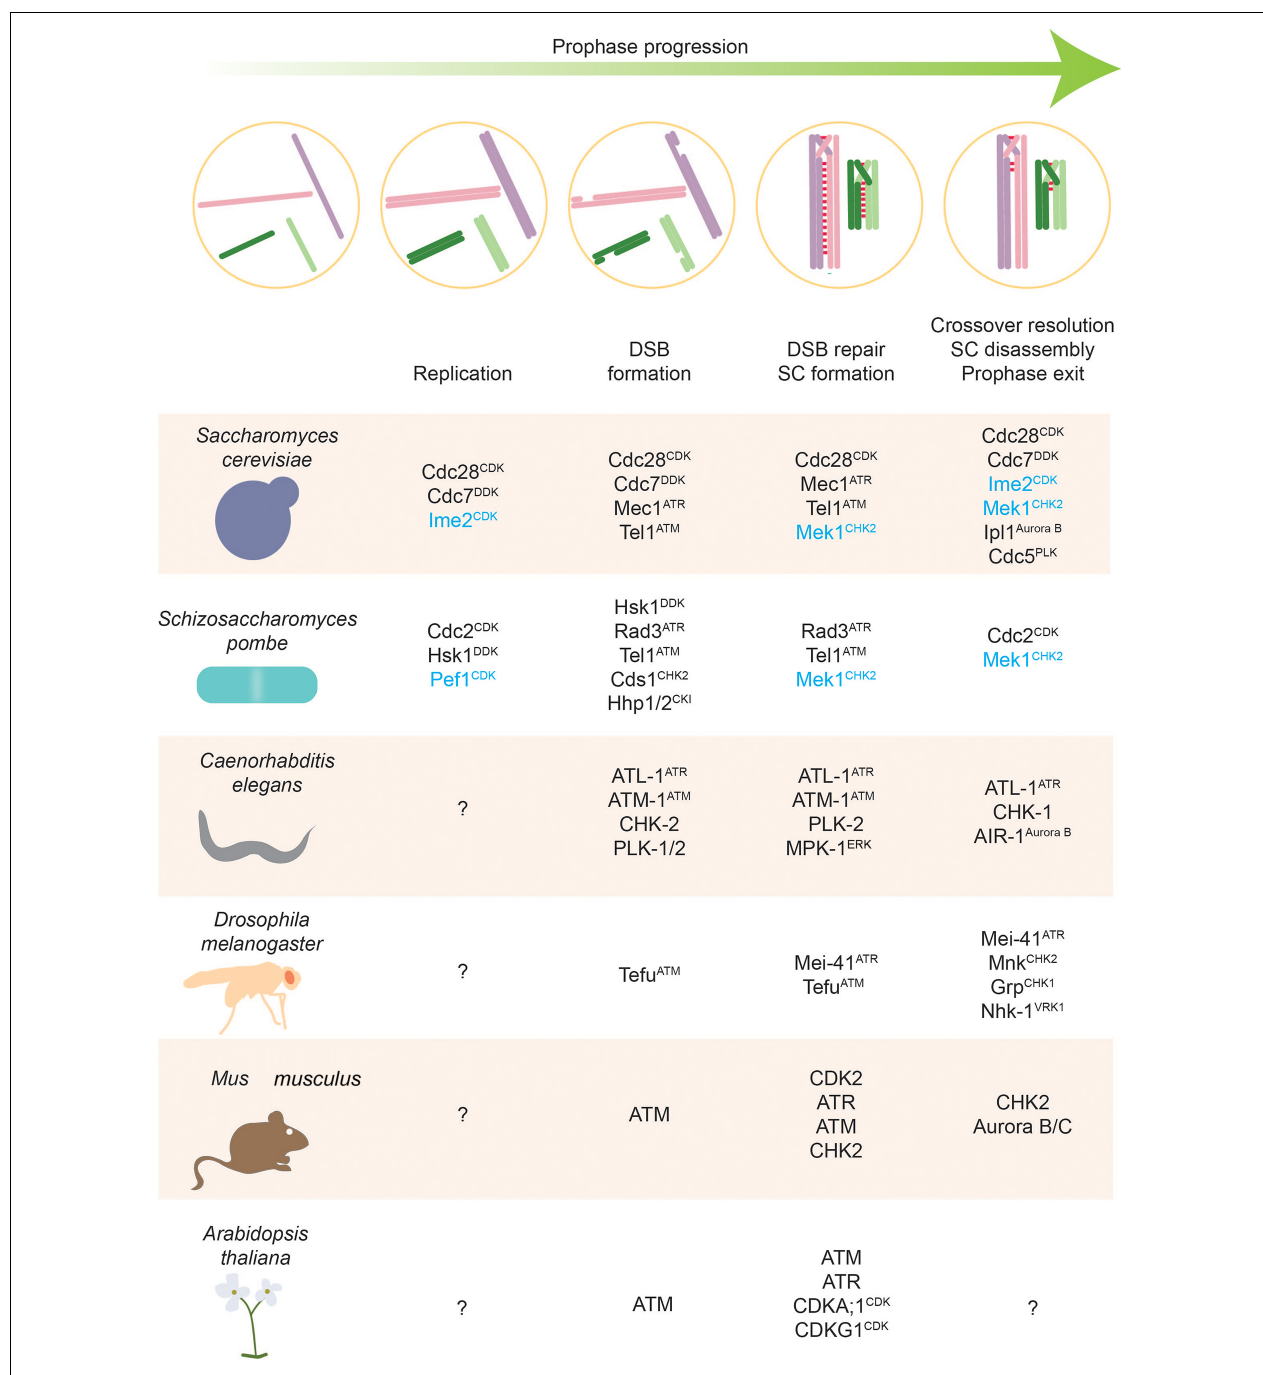
FIGURE 2 | Stages of meiosis and kinases that regulate them. Kinases along with phosphatases are the main actors of phosphorylation-based regulatory control. This figure highlights kinases with defined roles in different meiotic stages. Meiosis-specific kinases are colored